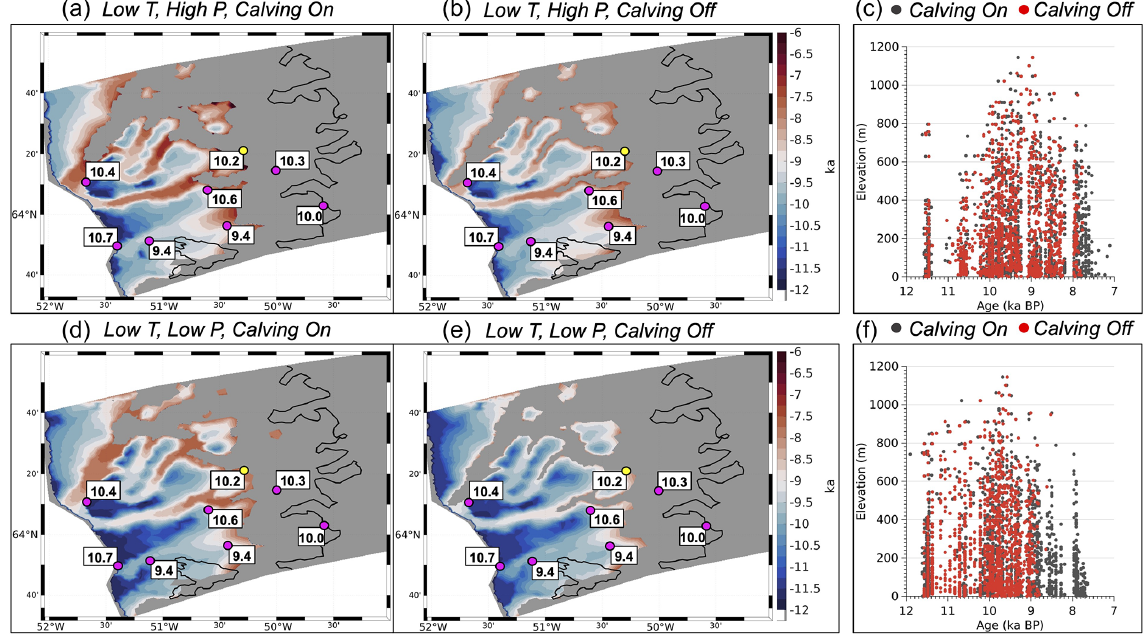
Figure 6. Map of simulated deglaciation ages for low-temperature scenarios with (a) high-precipitation and calving on, (b) high precipitation and calving off, (d) low precipitation and calving on, and (e) low precipitation and calving off. Gray mask is the simulated ice extent at present day, and the black line denotes the actual present-day ice extent (Rignot and Mouginot, 2012). Magenta circles are the best estimate of the timing of deglaciation at that point based on 10 Be surface exposure ages in thousands of years, and the yellow dot shows a minimum limiting radiocarbon age that requires ice-free conditions in the fjord at that time (Weidick et al., 2012; Young et al., 2021). Scatter plot of simulated deglaciation age (above sea level) versus bedrock elevation for (c) low temperature and high precipitation and (f) low temperature and low precipitation. Red dots are from simulations without calving, and black dots are for simulations with